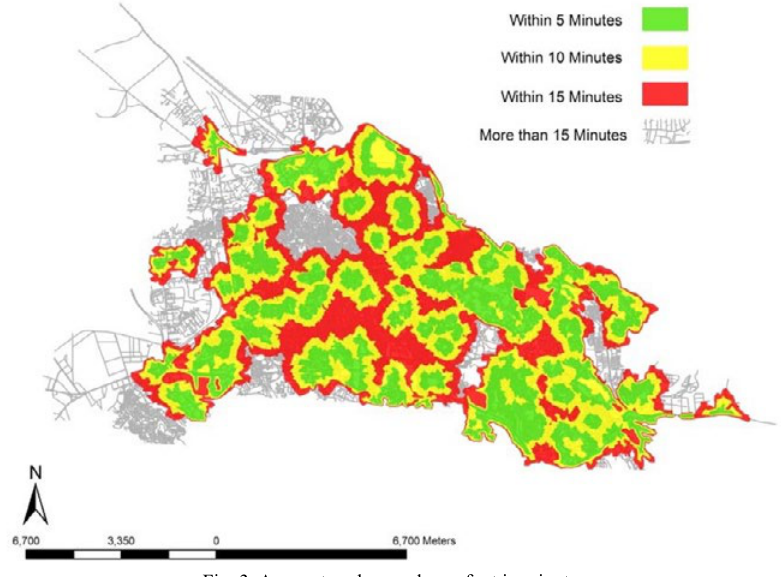
Fig. 3: Access to urban parks on foot in minutes Table 1: Areas outside the service coverage of urban green spaces based on over 15 minute walk Districts